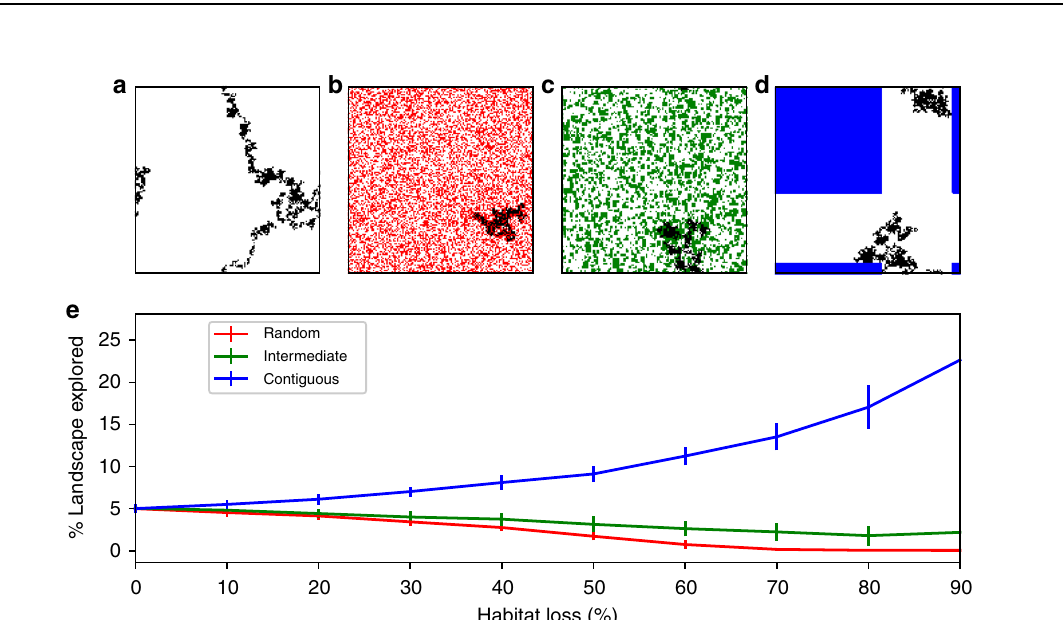
Fig. 5 Individual movement patterns under different habitat loss types. Top row: example trajectory for a single individual over 5000 time steps in a pristine landscape; b 40% random HL; c 40% intermediate HL; d 40% contiguous HL. Pristine landscape cells shown in white, destroyed cells in red and blue for random and contiguous HL, respectively. Green cells refer to destroyed cells under the intermediate HL scenario. Bottom row e : Fraction of pristine landscape explored by an individual during 5000 time steps. Solid lines indicate mean over 100 repeat runs; error bars indicate ±1 standard